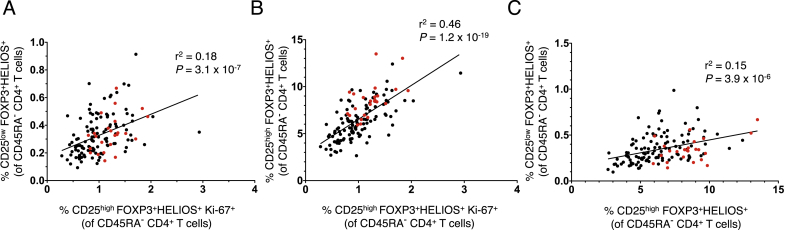
Proliferating Ki-67+CD25highFOXP3+HELIOS+Tregs correlate with the frequencies of the CD25lowand CD25highCD127lowFOXP3+HELIOS+subsets. (A, B) Data shown depict the correlation between the frequency within CD45RA− CD4+ T cells of in-cycle (Ki-67+) CD4+CD45RA− CD127lowCD25high Tregs (FOXP3+HELIOS+) and the frequency of either CD25low FOXP3+HELIOS+ T cells (A) or conventional CD25high FOXP3+HELIOS+ Tregs (B). (C) Data shown depict the correlation between the frequencies of circulating CD4+CD45RA− CD25low FOXP3+HELIOS+ and CD25high FOXP3+HELIOS+ T cells. Frequencies of the assessed immune subsets were measured in PBMCs from healthy volunteers from two independent cohorts: cohort 1 containing 24 donors (depicted in red) and cohort 2 containing 112 donors (depicted in black). The r2 values represent the coefficient of determination of the linear regression in the combined cohorts, and the P values correspond to the F statistic testing the null hypothesis that the slope of the linear regression analysis is equal to 0.